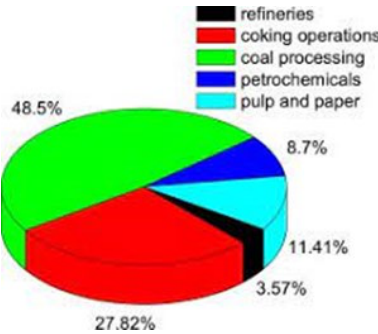
Figure 8. Phenol concentration in the effluent of major industries. Reproduced with permission from ref. [64]. Copyright 2019 Elsevier.